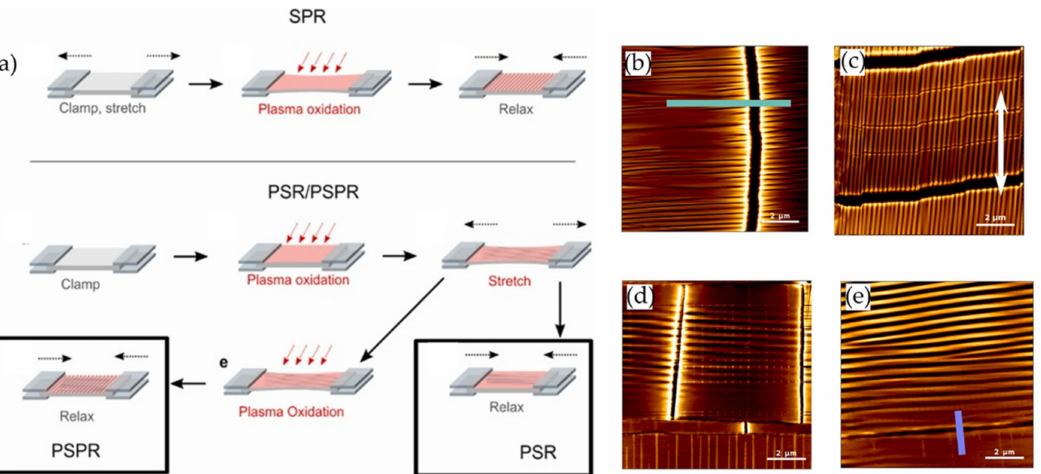
Figure 21. ( a ) PDMS wrinkle manufacturing process, micrographs of wrinkles, ( b ) SPR, ( c ) PS, ( d ) PSR, and ( e ) PSPR. Reproduced with permission from reference [78]. Copyright 2022, Elsevier Ltd.